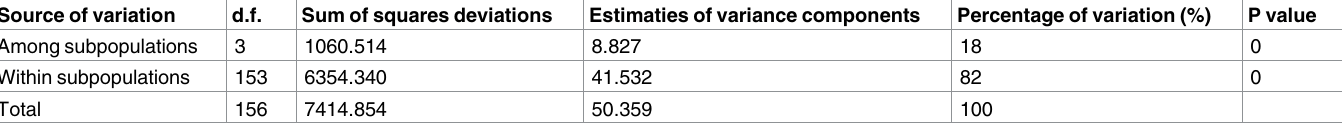
Table 4. Analysis of molecular variance(AMOVA) for the subpopulations as identified in STRUCTURE analysis. Source of variation